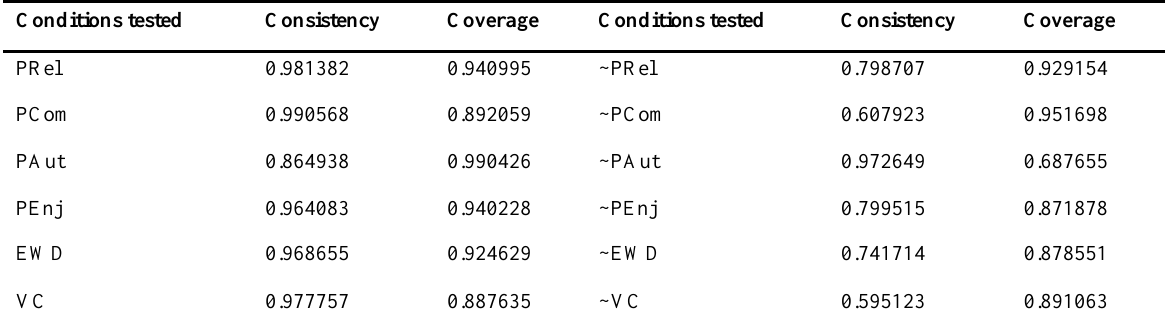
Table 7 : Analysis of Necessary Conditions (Outcome variable: